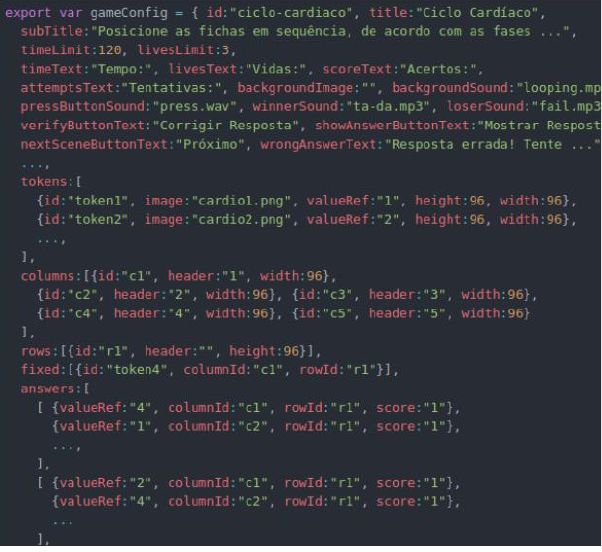
Figure. 4. Partial example of a JSON model configuration representing one of the modeled cardiac cycle